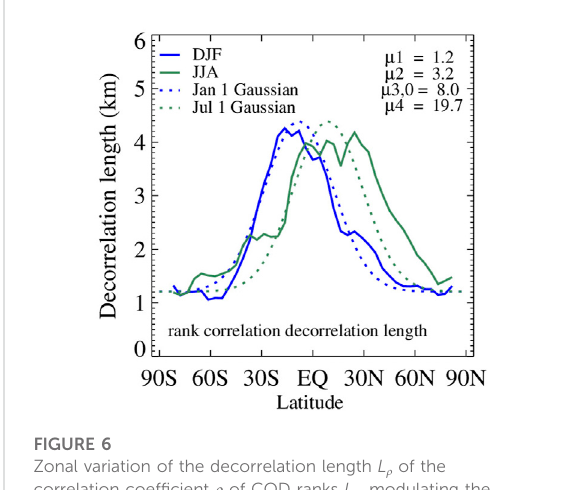
FIGURE 6 Zonal variation of the decorrelation length L ρ of the correlation coef fi cient ρ of COD ranks L ρ , modulating the exponential decay of ρ vs. separation distance according to Eq. 3, forDJFandJJAalongwithGaussian fi tsaccordingtoEq.7for January 1st and July 1st.